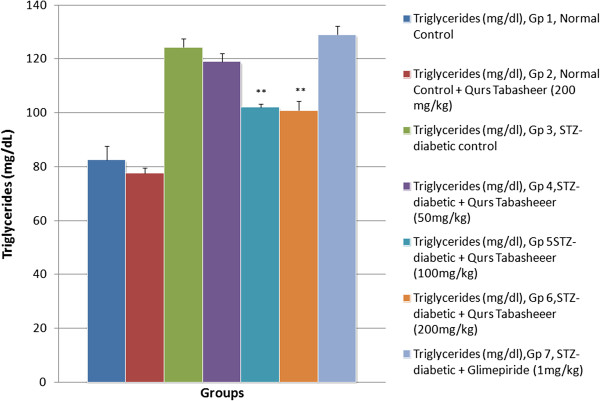
Effect of Qurs Tabasheer on serum triglycerides at different concentrations on normal and STZ induced diabetic rats, compared to standard drug Glimepiride; values are mean ± SEM; n = 6; *P < 0.05; **P < 0.01; ***P < 0.001; P > 0.05 is considered as non-significant (ns).